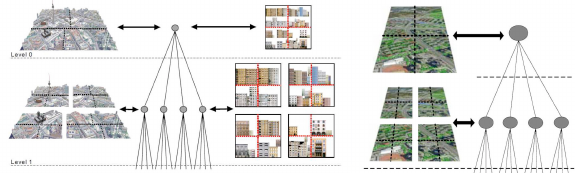
Figure 4. Structure of the texture-atlas tree (Buchholz & Döllner, 2005) and Structure of the texture quad-tree (Wen et al.,